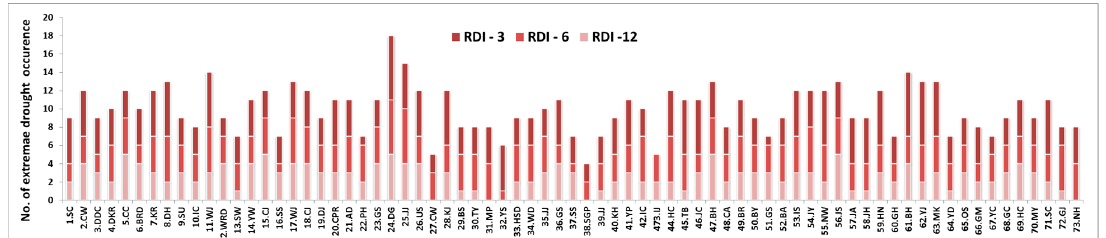
Figure 7. Number of occurrences of extreme drought in each observatory (RDI).